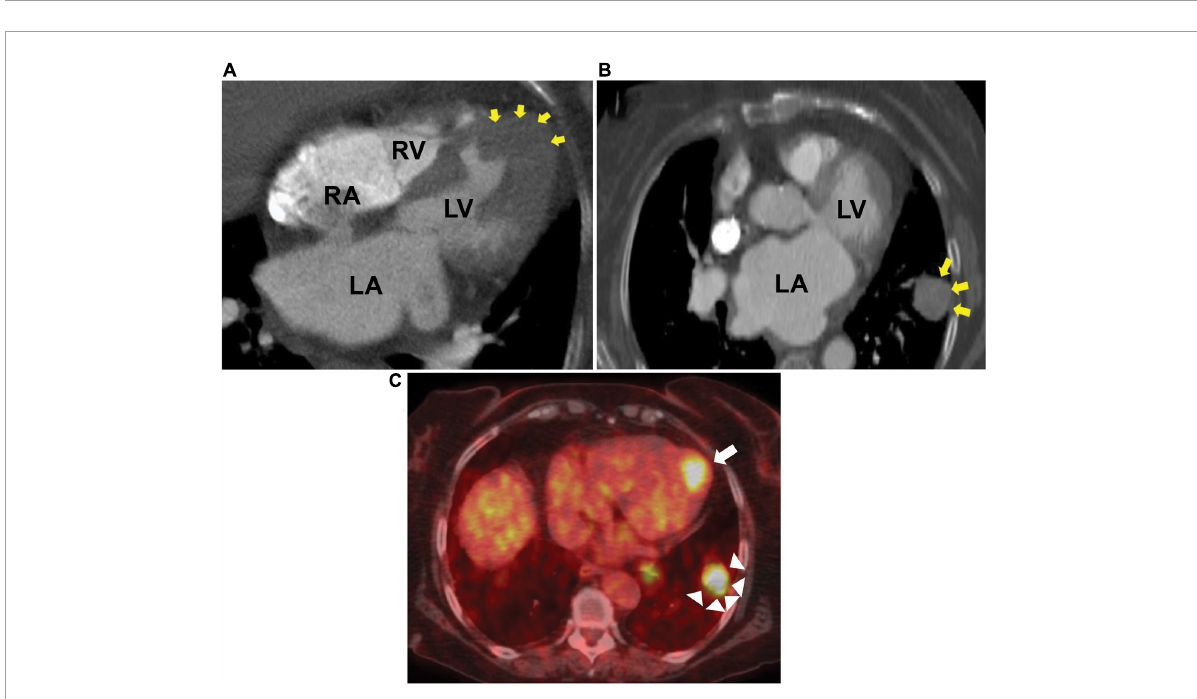
FIGURE3 Chest CT and PET scan. Computed tomography (CT) showing metastatic melanoma involving the left ventricular apical wall (A) , left lung (B) , and positron emission tomography (PET) scan axial image (C) showing increased fluorodeoxyglucose uptake in the left ventricular apex (arrow) and left lung (arrow heads). LA, left atrium; LV, left ventricle; RA, right atrium; RV, right ventricle.